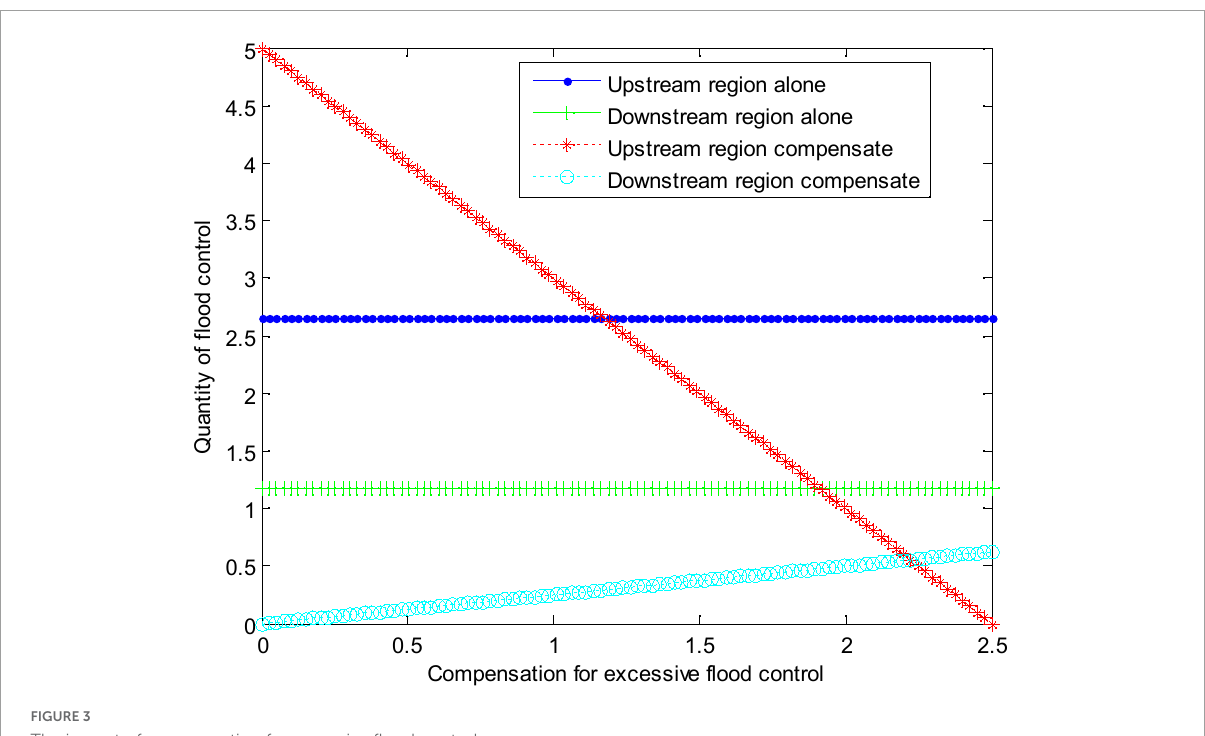
FIGURE3 The impact of compensation for excessive flood